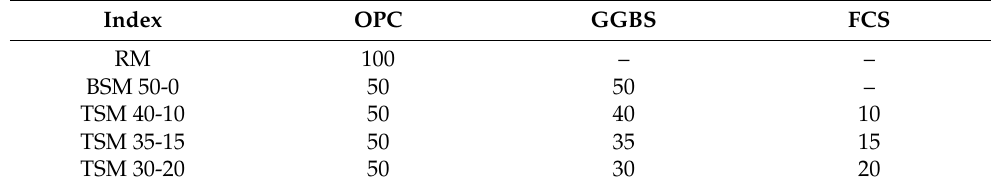
Table 8. Blended cement compositions (%).